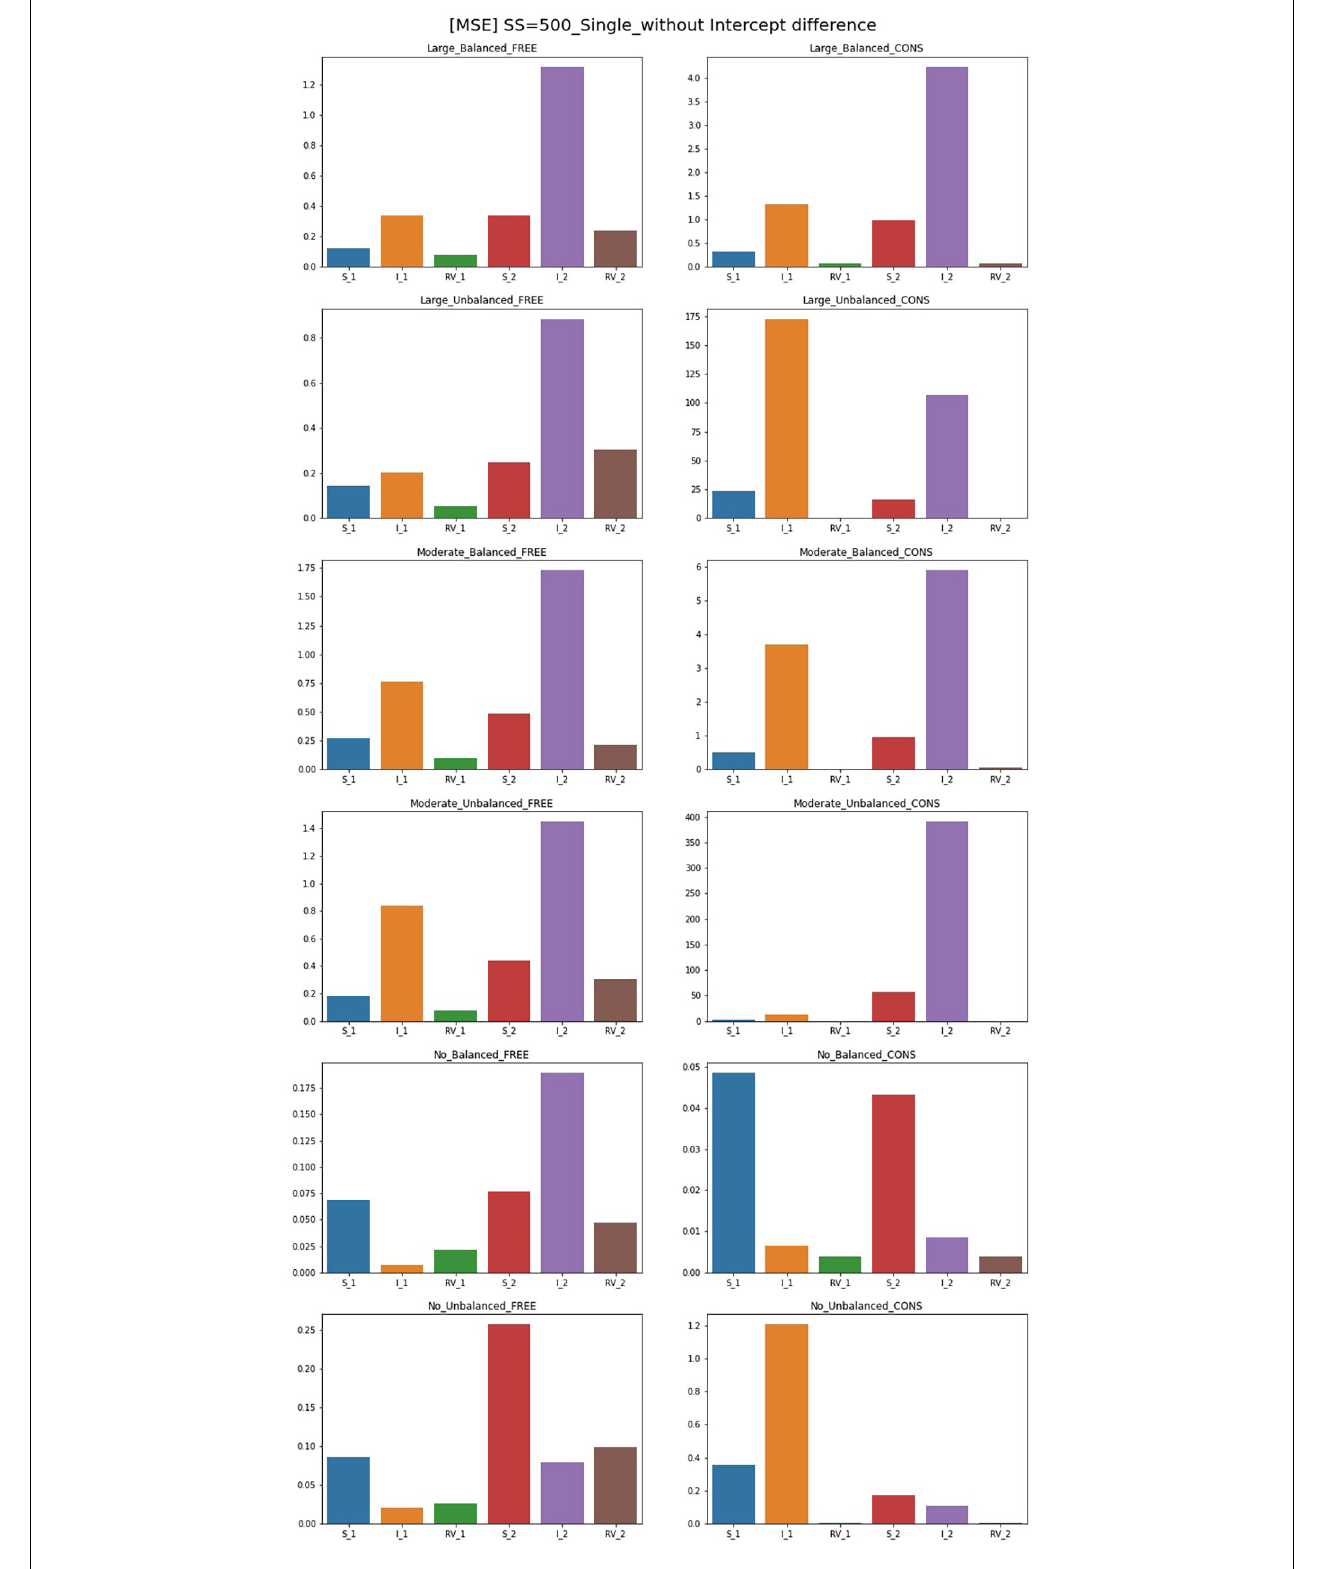
FIGURE 4 | MSE of single-predictor models (sample size = 500, without intercept difference). Free, residual variances freely estimated; Cons, residual variances equally constrained; S_1, slope for class 1; RV_1, residual variance for class 1; S_2, slope for class 2; RV_2, residual variance for class 2.